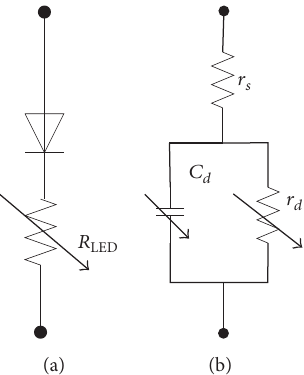
Figure 3: LED model in conduction mode for (a) DC mode and (b) AC mode.